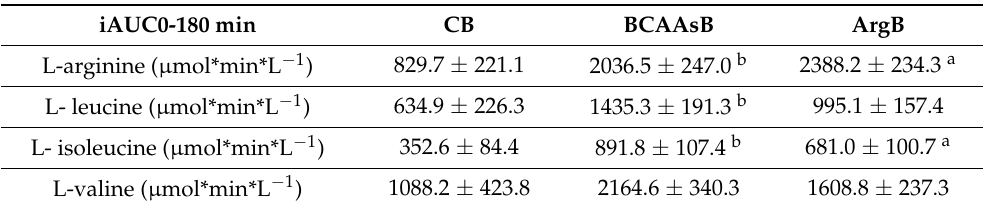
Values are expressed as mean ± SEM ( n = 30). a p < 0.05 between ArgB and CB, b p < 0.05 between BCAAsB and